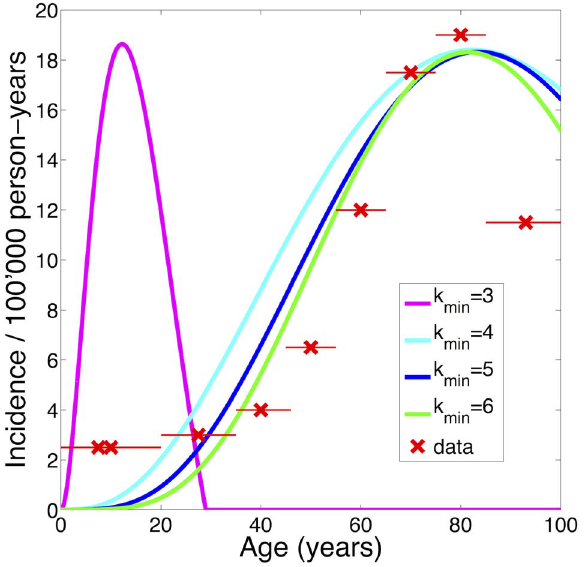
Figure 2. Influence of k min on location of peak incidence. Representative incidence curves for k min ~ 3 (magenta), k min ~ 4 (cyan), k min ~ 5 (blue) and k min ~ 6 (green). Only for k min § 4 can the condition of peak incidence at approximately 80 years be fulfilled. Incidence curves generated by the model for k min ~ 4 , 5 and 6 are in accordance with the demographic data from [1] (red crosses: mean incidence of age groups, red lines: spans of age groups), with k min ~ 6 yielding the best fit. Confidence intervals are shown in Fig. S1.